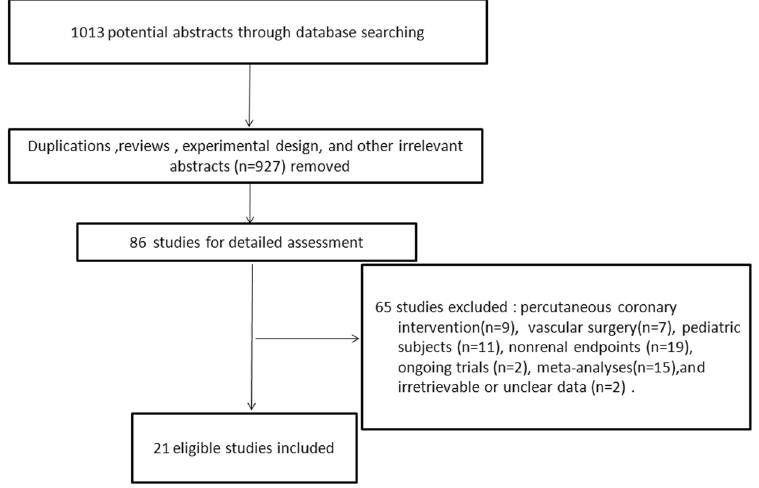
Figure 1. Screening and selection process of eligible RCTs for inclusion in this meta-analysis according to